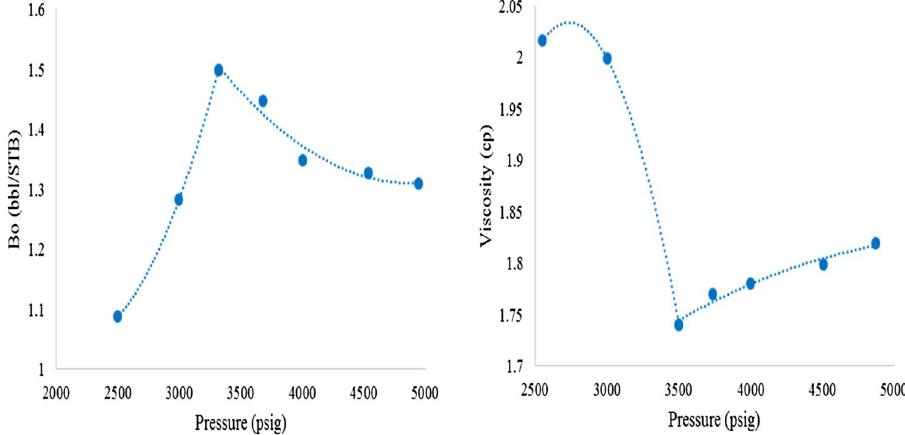
Fig. 6 Results of Glaso (1980) and Beal (1946) correlations and experimental